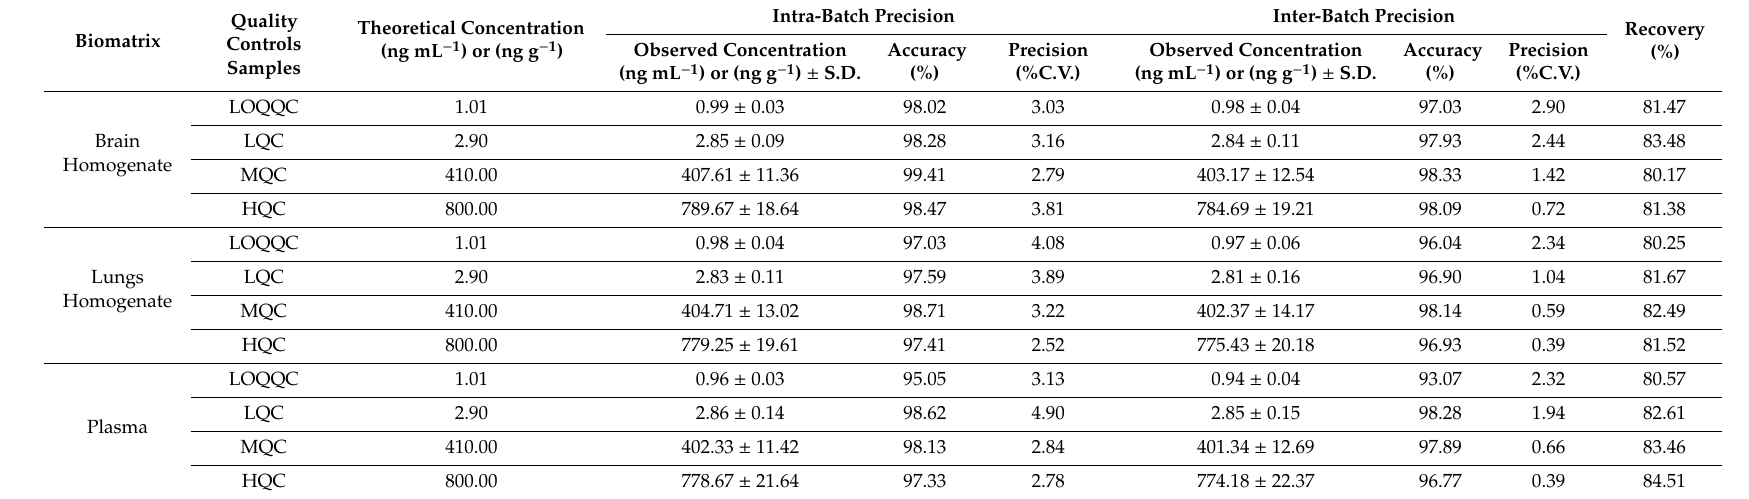
Table 6. Validation: precision and accuracy data for catechin hydrate (CH) in di ff erent biomatrixes. LOQQC, lower limit of quantification for quality control; LQC, lower QC; MQC, medium QC; HQC, high